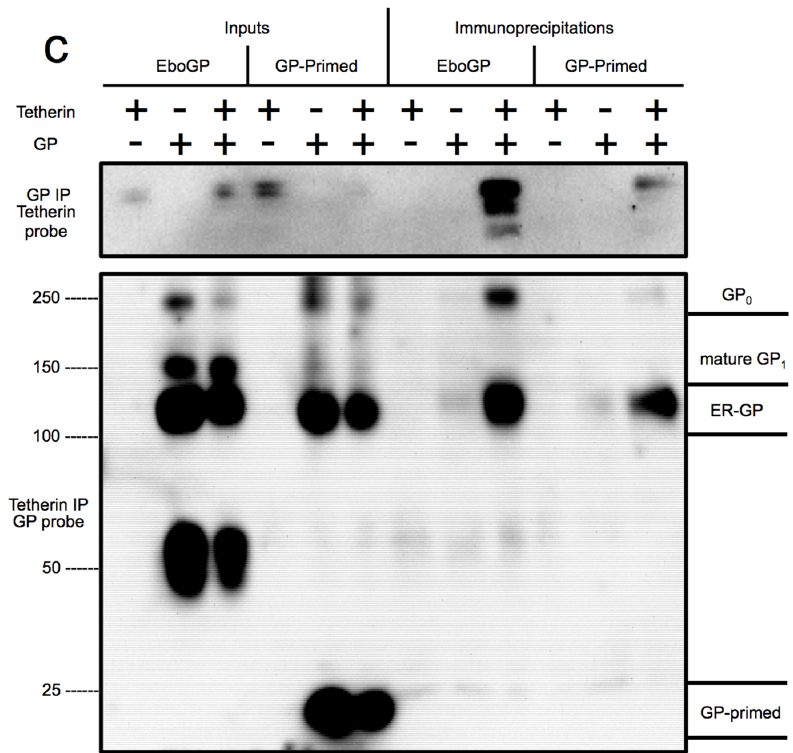
Figure 4. ( a ) Schematic diagram depicting the domains of EboGP and GP-primed, a construct that mimics the glycoprotein produced during Ebola virus entry by introduction of a furin cleavage site at the position where cathepsin processing normally occurs; ( b ) Ebola VLP budding assay comparing GP-primed to EboGP. Top Panel : Purified supernatants of 293T cells transfected with the indicated expression plasmids were analyzed by SDS-PAGE and probed with anti-FLAG antibody to detect FLAG tagged VP40. Middle Panel: 293T cells producing the VLPs were lysed in TritonX-100 buffer, analyzed by SDS-PAGE and immunoblot using α -FLAG antibody. Bottom Panel: The blot from the middle panel was stripped and re-probed with polyclonal antibody against GP to detect the differential forms of the filovirus glycoproteins; ( c ) EboGP and GP-primed interactions with tetherin. Analysis of cell lysates (input) or immunoprecipitated proteins from 293T cells transfected with tetherin and EboGP or GP-primed as indicated. Top Panel: Precipitation using polyclonal α -EboGP sera flowed by SDS-PAGE and detection with an α -tetherin monoclonal antibody. Bottom Panel: A reciprocal analysis, using an α -tetherin antibody for immunoprecipitation and detection with α - EboGP sera. Molecular mass is shown in kD. Indicated on the right are the immature (ER) form of the Ebola virus glycoprotein, GP 0 and the mature forms of GP-primed and EboGP.